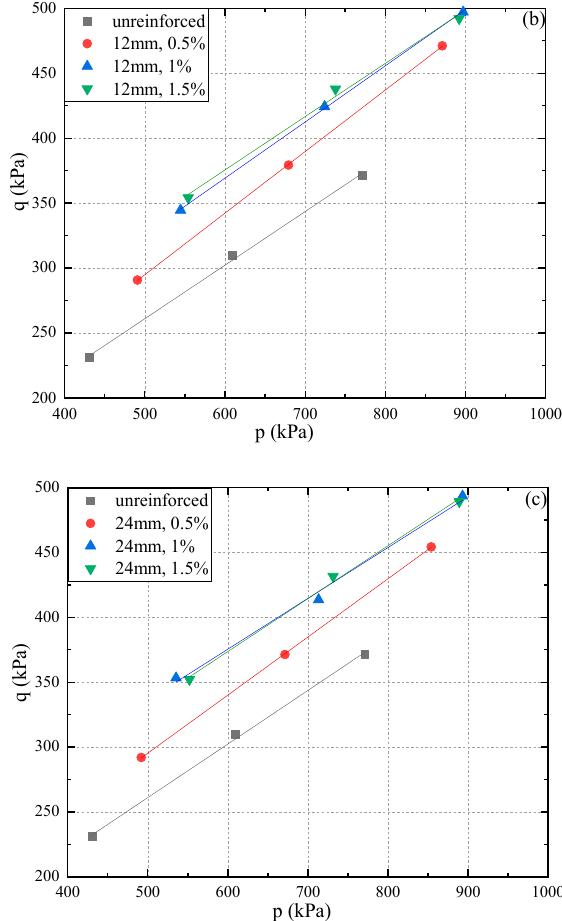
Figure 12. Lines for the polypropylene (PP) fiber-reinforced FAS specimens with various fiber lengths and fiber contents, ( a ) FC = 6 mm, ( b ) FC = 12 mm, ( c ) FC = 24 mm.